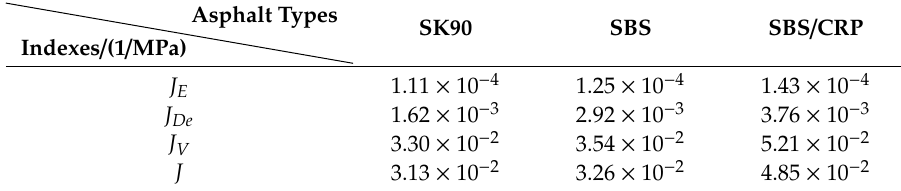
Table 7. Parameters of comprehensive creep